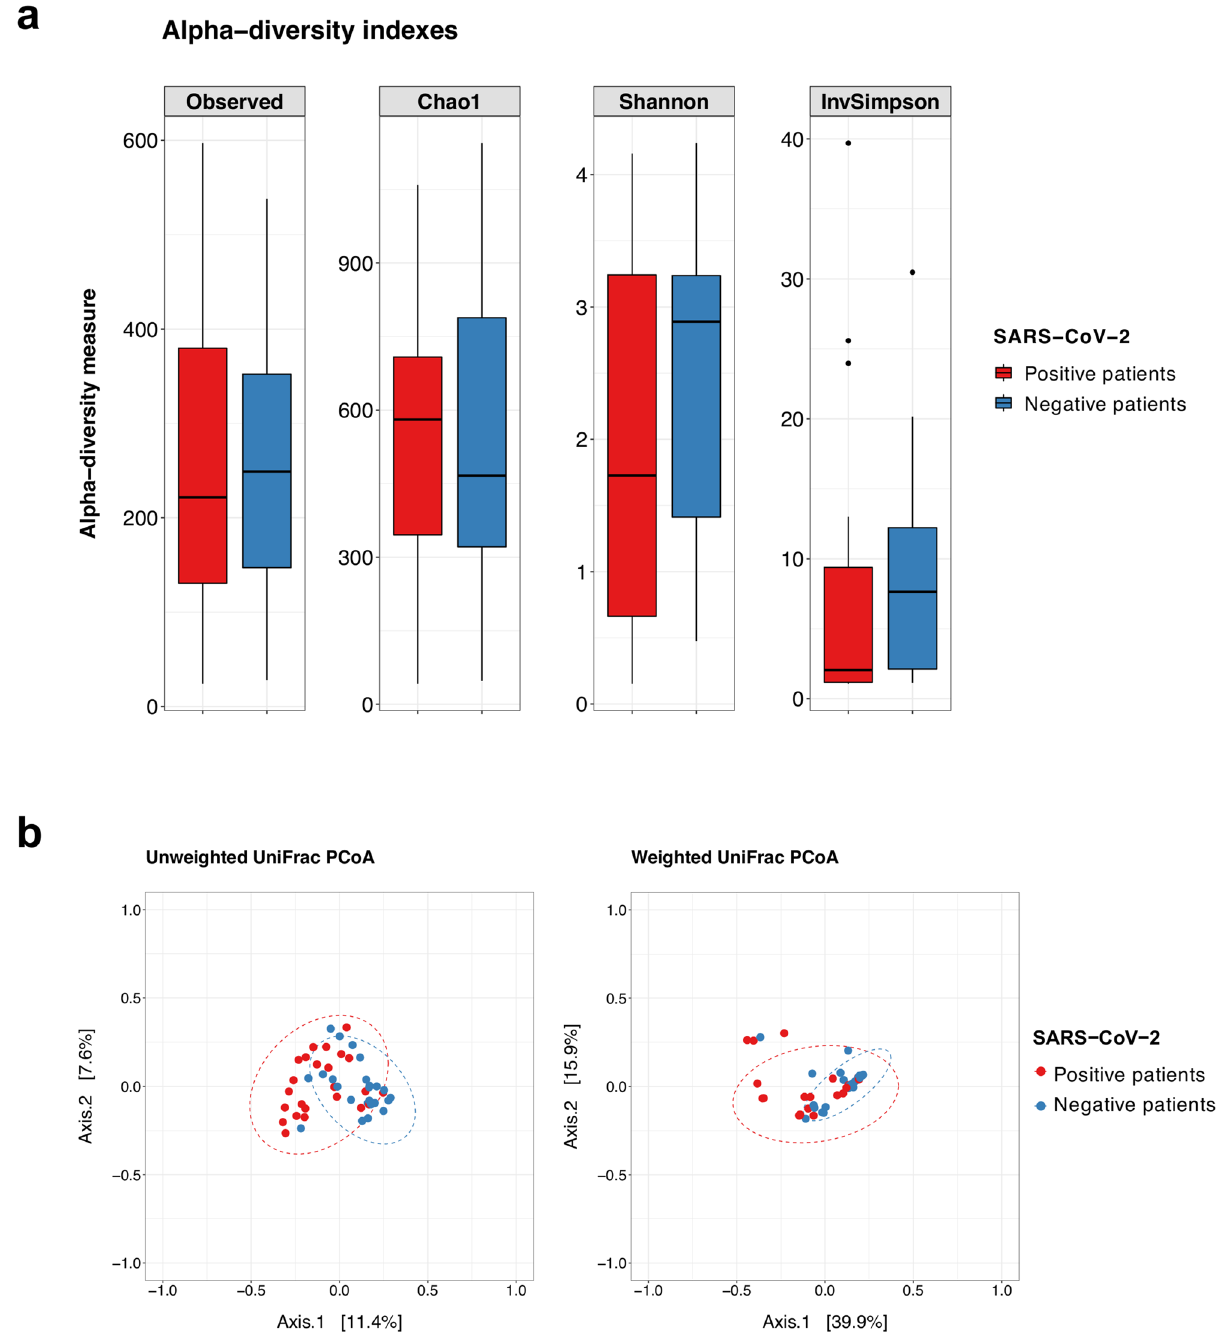
Figure 1. ( a ) Boxplots with whiskers showing the comparison of alpha diversity measures between SARS- CoV-2 positive patients (n = 24) and negative patients (n = 24). No significant differences were found between the two study groups. Median, first and third quartile and outliers are shown. ( b ) Principal Coordinate Analysis (PCoA) on unweighted and weighted UniFrac distance metric at the OTU level calculated on COVID-19 positive (n = 24, red dots) and COVID-19 negative patients (n = 24, blue dots). Each sample is represented by a dot. Axis 1 explained 12% and 40% of the variation observed, in the left and right graph, respectively, and Axis 2 explained 8% and 16% of the variation, in the left and right graph,